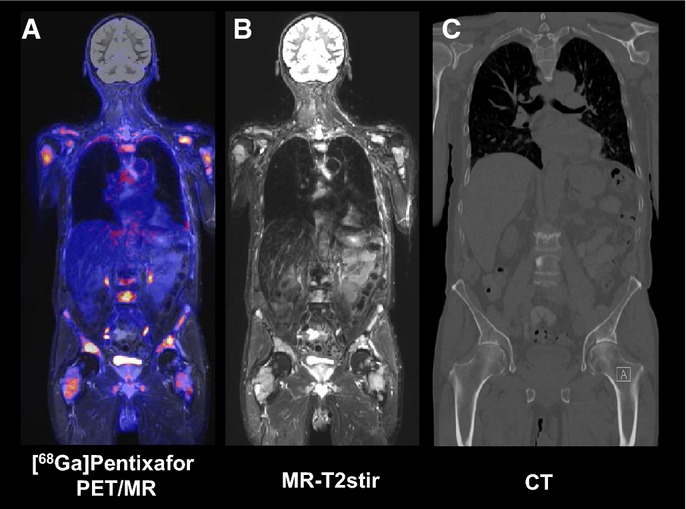
[68Ga]Pentixafor PET/MR images
A–C Coronal views of [68Ga]Pentixafor (A), T2 STIR weighted MRI (B) and CT bone window (C) of a male patient with histologically proven multiple myeloma. The increased [68Ga]Pentixafor uptake correlates with the hyperintense T2 STIR signal; however, the myeloma manifestations are underestimated in the corresponding bone window CT.